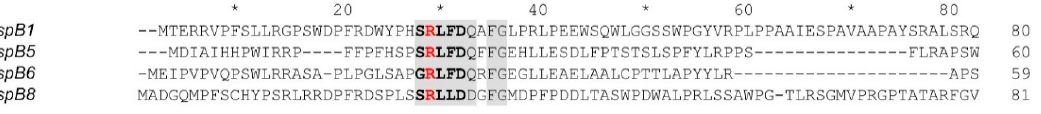
Figure 1. Alignment of the primary structure of the N-terminal domains (NTD) of four human small heat shock proteins (sHsp). The conserved (S/G)RLFD(D/Q)xFG motif is marked grey, the conserved pentapeptide is depicted in bold letters, the conserved Arg residue is marked red. The following sequences from Uniprot were used: P04792 (HspB1), P02511 (HspB5), O14558 (HspB6), Q9UJY1 (HspB8). Multiple alignment was generated by Tcoffee.